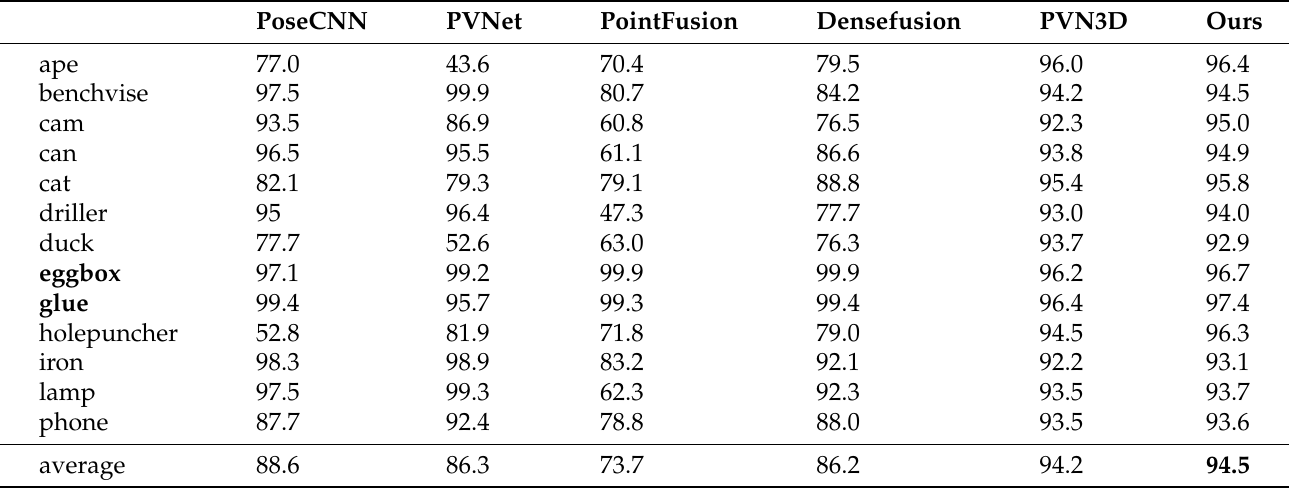
Table 1. The accuracies of our method and the baseline methods on the LINEMOD dataset in terms of the ADD(-S) metric, where the bold are considered as symmetrical objects.